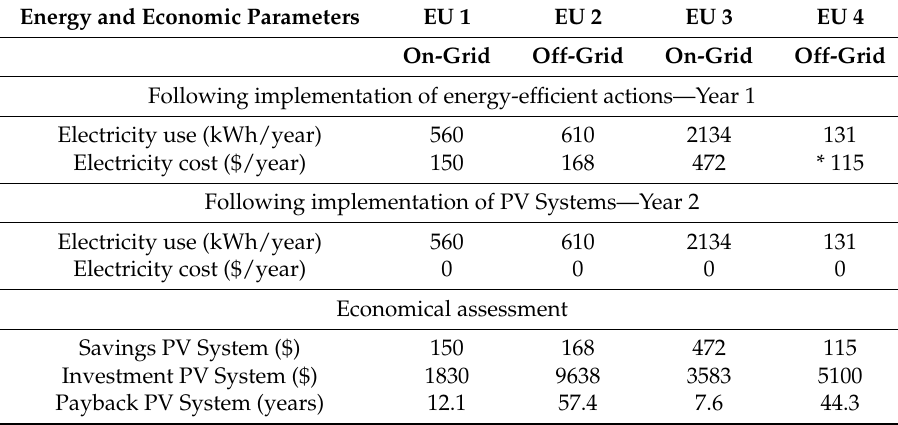
Table 7. Economical assessment of each